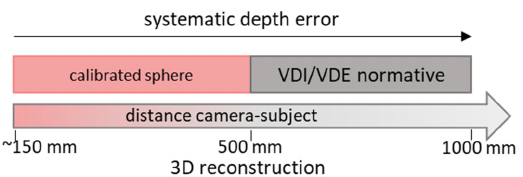
Figure 5. The proposed framework for the characterization of the device: a certified sphere is used in the very-close range (<500 mm); up to 1000 mm, the VDI/VDE 2634 Part 2 standard is applied; the systematic depth errors are evaluated on the entire range; and the 3D reconstruction of an object is tested for a camera–subject distance of 500 mm.